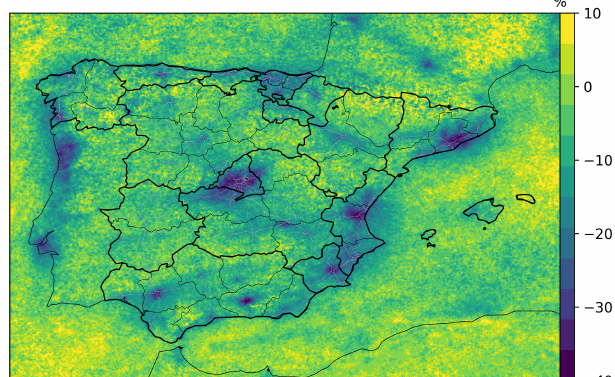
Figure 8. Mean relative change of TROPOMI TrC-NO 2 during the weekend (Saturday–Sunday) relative to the week (Monday–Friday), over the Iberian Peninsula. Black lines and grey lines correspond to administrative borders and Spanish major roads, respectively (sources: see Sect. 2.4).